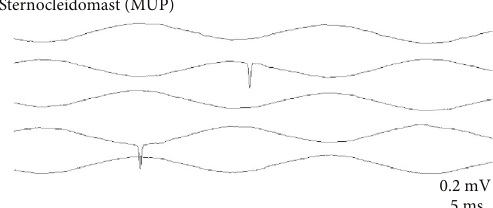
Figure 6: Electromyogram on day 28 after saline administration. No SEA